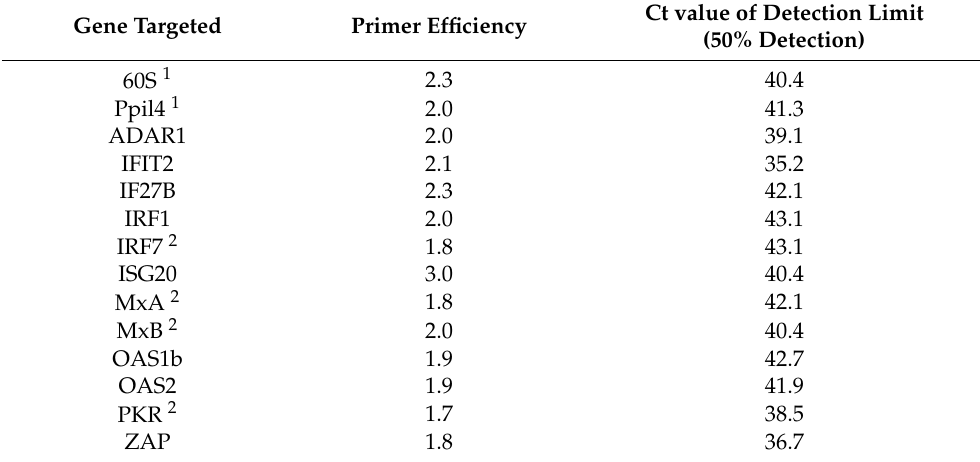
Table 2. Primer efficiencies and limits of detection of the RT-PCR-based